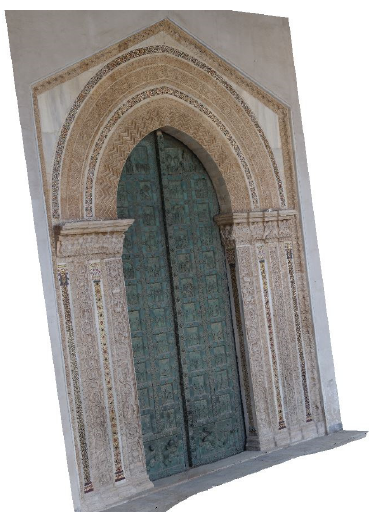
Figure 13. 3D model of the main portal of Cathedral of Monreale